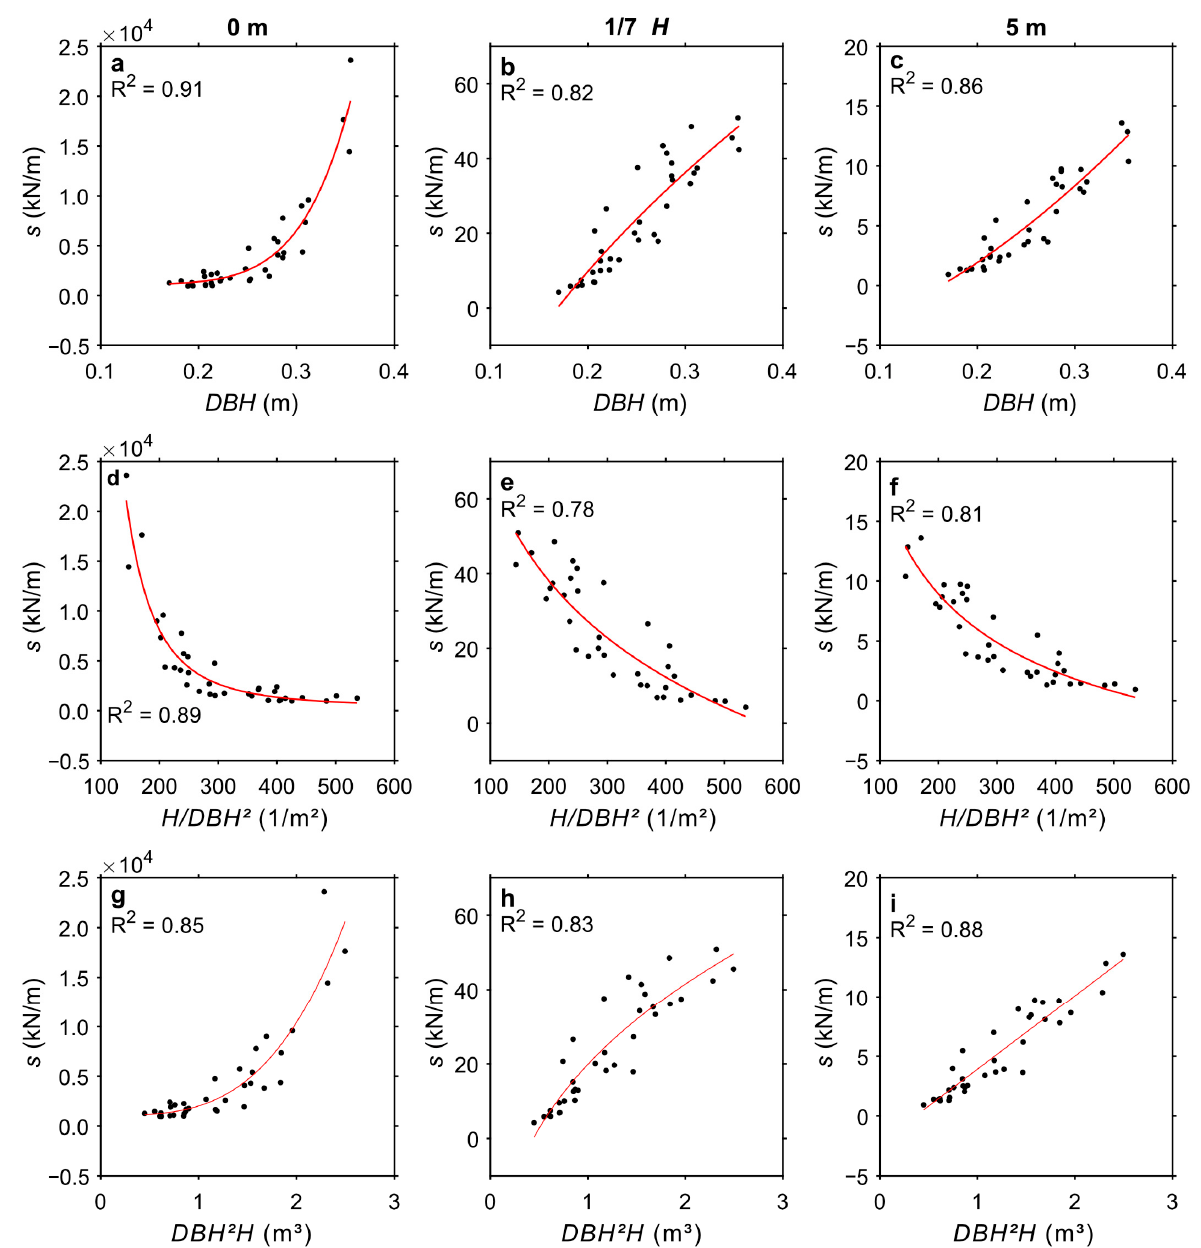
Figure 5. Slope ( s ) as a function of DBH (1.3 m a.g.l.), H/DBH² , and DBH²H of the sample trees B1